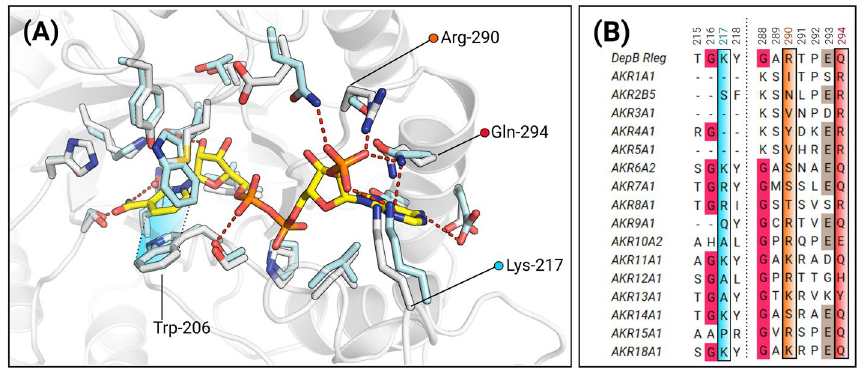
Figure 4. Model of the coenzyme binding site highlighting the conservation of putative coenzyme binding residues. ( A ) NADP + was modeled by superimposing the ternary complex of AKR6A2 with apo-DepB Rleg . White sticks represent the residues from DepB Rleg complex, while cyan sticks are residues corresponding to AKR6A2. Trp-206 has been re-oriented in the apo-DepB Rleg structure to prevent a steric clash with the nicotinamide ring of NADP + . π-stacking interactions between the nicotinamide ring and Trp-206 are shaded in blue. In apo-DepB Rleg , Lys-217 points away from the entrance of the coenzyme binding pocket. However, by analogy to Lys-254 in AKR6A2, this residue may interact with at least one of the oxygen atoms of 2’monophosphate. ( B ) MSA depicting conservation of residues near the 2’monophosphate of the modeled NADP + (See Supplementary Table S1 for accession codes).